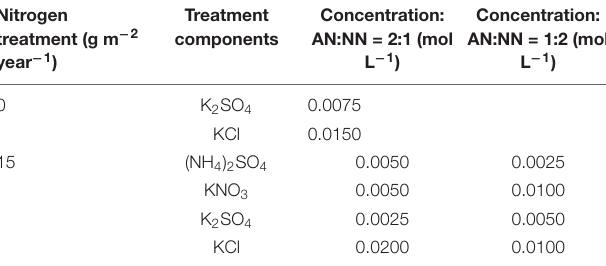
FIGURE 1 | Plant species used for this experiment. (A) Invasive Wedelia trilobata . (B) Native Wedelia chinensis .